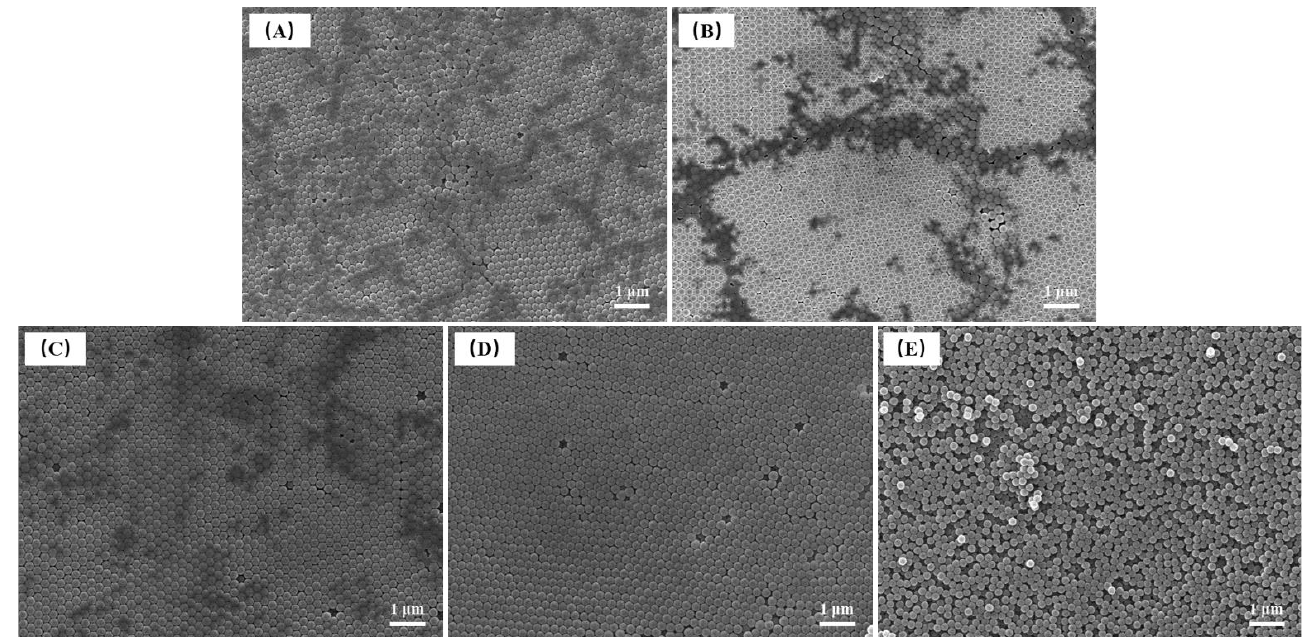
Figure 2. FE-SEM images of P(St-AA) colloidal microspheres synthesized with different emulsion polymerization times: ( A ) 6 h; ( B ) 8 h; ( C ) 10 h; ( D ) 12 h; ( E ) 14 h. polymerization times: ( A ) 6 h; ( B ) 8 h; ( C ) 10 h; ( D ) 12 h; ( E ) 14